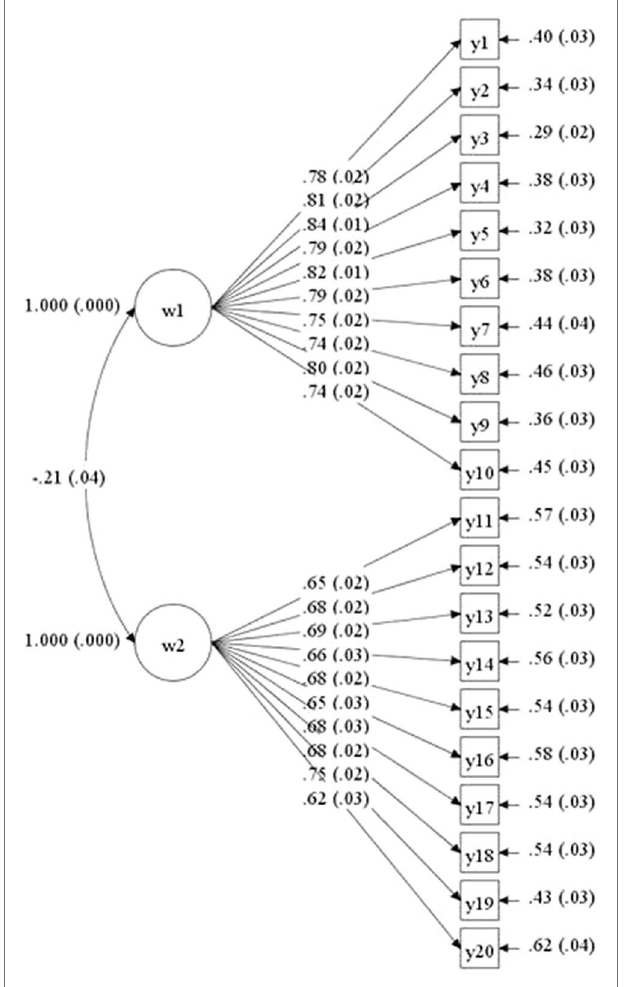
FIGURE 2 | Corrected two-factor model for the perceived broad group emotional climate (PBGEC).